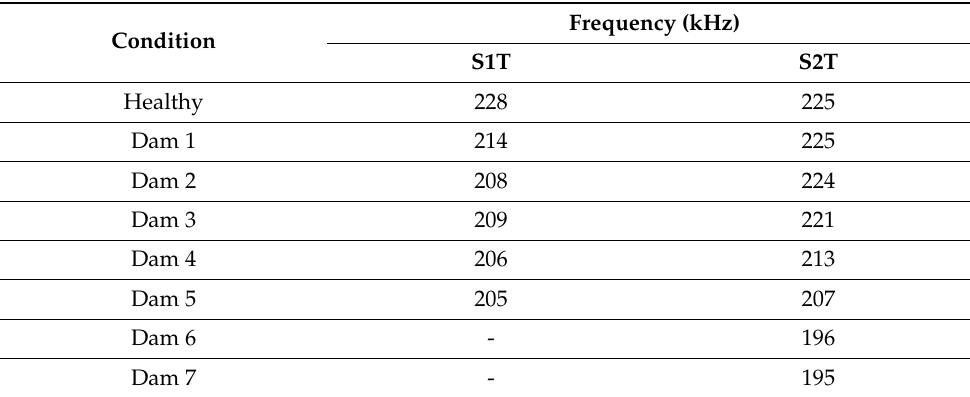
Table 2. Peak voltage response